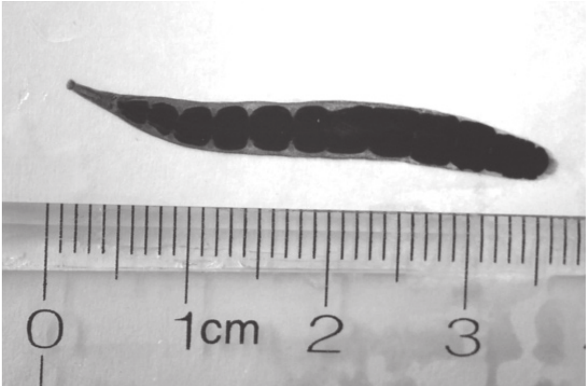
Fig. 2. – A specimen of Myzobdella lugubris compressed and stained with Mayer’s